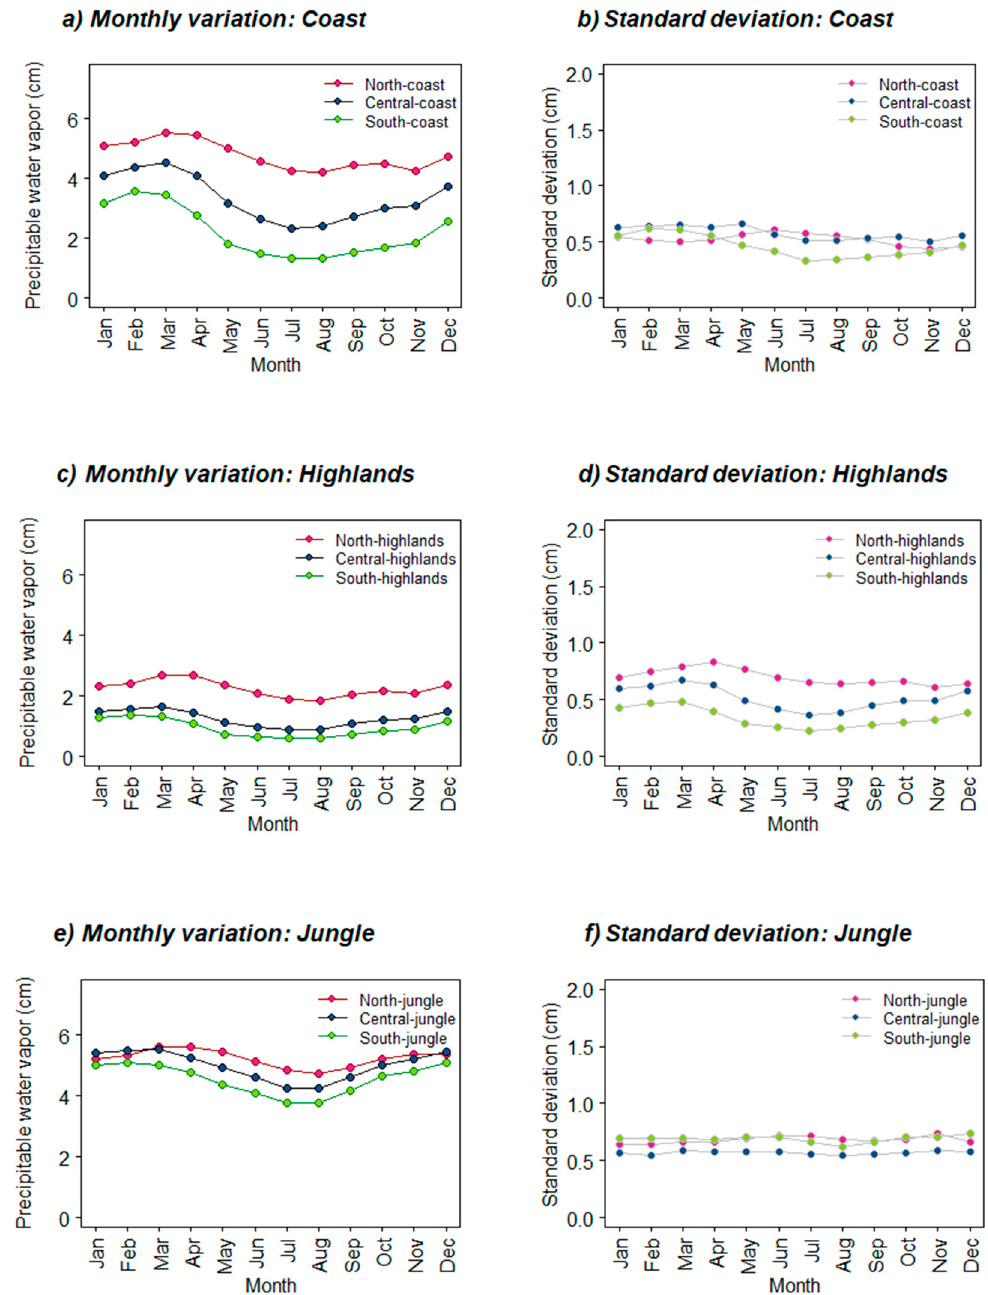
Figure 4. Analysis of PWV variations at monthly level (mean values and standard deviation) using MODIS PWV product (2000–2017): ( a , b ) for the Coast region, ( c , d ) for the Highlands region, and ( e , f ) for the Jungle region.